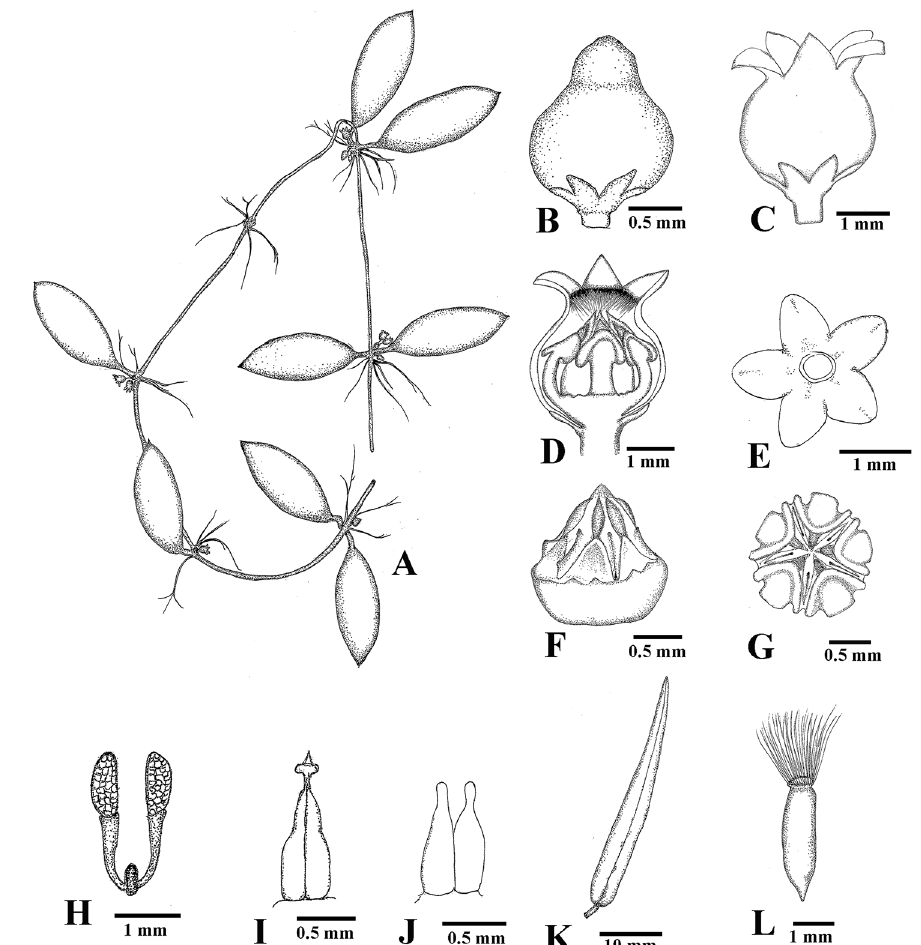
Figure 2. Dischidia phuphanensis . A Branch with leaves and inflorescences B bud C flower D dissected flower with half of corolla removed E calyx from abaxial side F gynostegium (side view), with coronal lobes removed G gynostegium (from above) H pollinarium I pistil J pistil (style-head removed) K follicle L seed A–J drawn by Wannachai Chatan from W. Chatan 2489 , and K, L from W. Chatan 2904